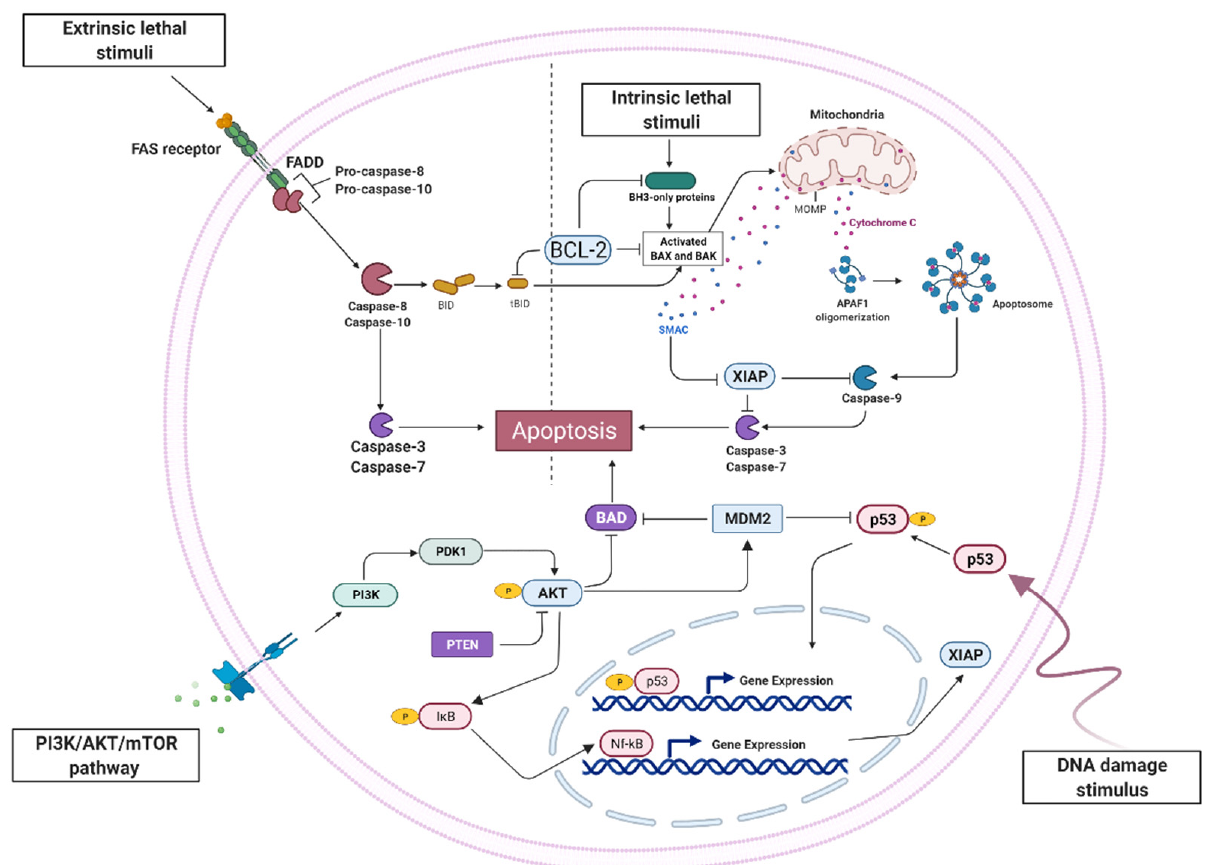
Figure 1. An overview of the signaling pathways that are involved in apoptosis in human glioblas- toma cells.